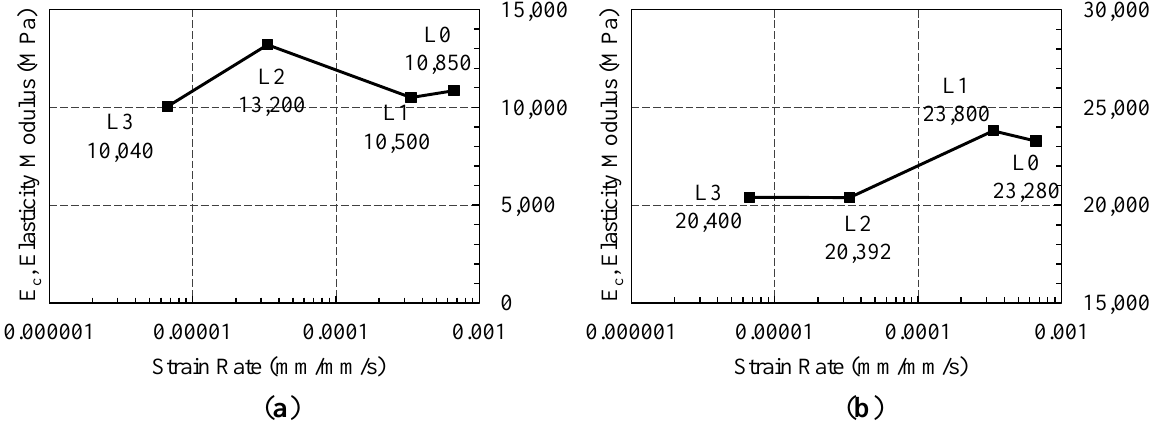
Figure 7. The variation of the elasticity modulus. ( a ) Low strength. ( b ) Medium strength.